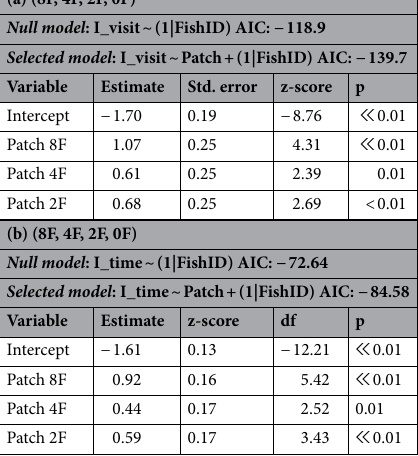
Table 1. Summary of results of generalized linear mixed models indicating effect of patch (female number) (fixed factor) and fish id (random factor) on (a) proportion of visits (I_visit) (b) proportion of time spent (I_time). The AIC values of selected models along with estimate values, t-scores, degrees of freedom (df) and p values for each factor are shown. p values ≤ 0.05 is considered significant. Patch0F, Patch2F, Patch4F, and Patch8F signify patches with 0, 2, 4, and 8 females, respectively.